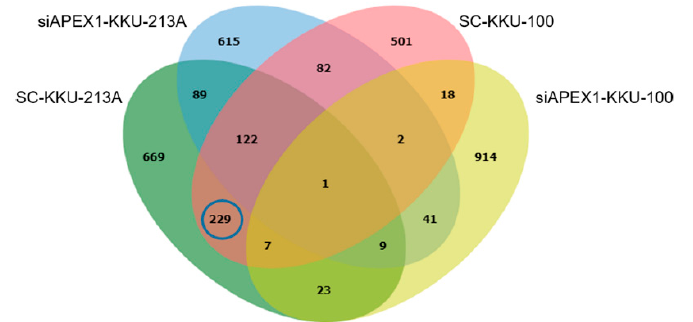
Figure 3. Venn diagram presenting the number of proteins in each sample and the degree of indi- vidual overlap among APEX1-gene silenced and scramble-treated KKU-213A and KKU-100 cells.